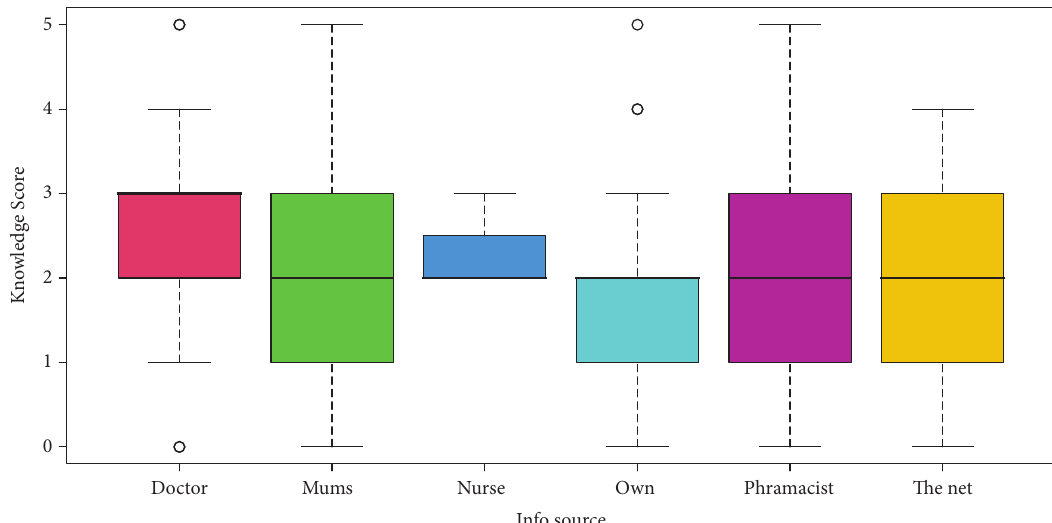
Figure 3: A visual display that consulting a doctor resulted in the highest knowledge score (red box) compared to other information source about weaning food choices.